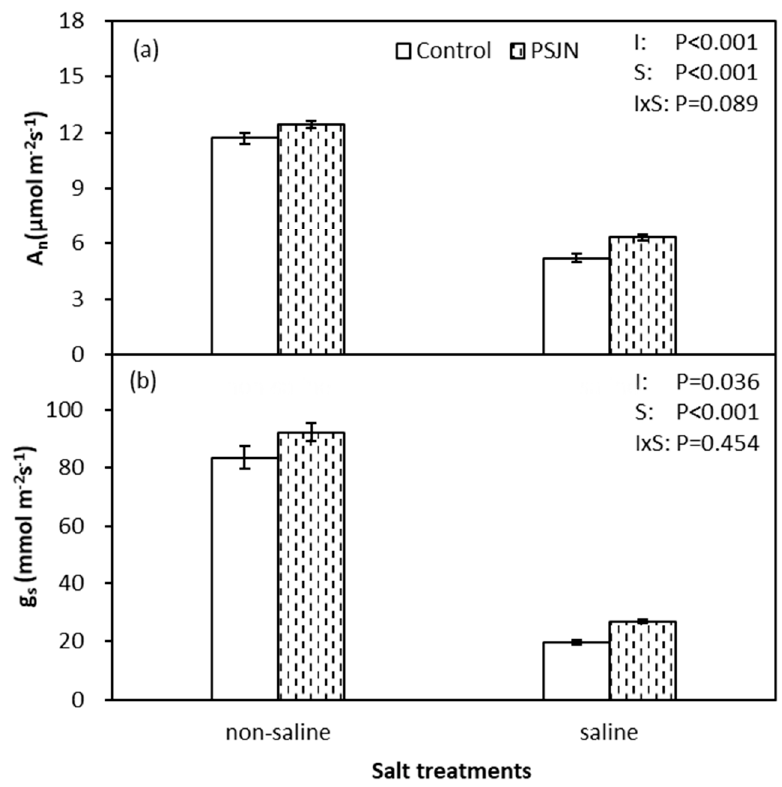
Figure 1. Photosynthetic rate (A n ) ( a ) and stomatal conductance (g s ) ( b ) of quinoa leaves a ff ected by bacterial inoculation in non-saline (0 mM NaCl) and saline (400 mM NaCl) irrigations. PsJN indicates Burkholderia phytofirmans PsJN. I and S indicate inoculation and salinity treatments, respectively, and I × S indicates the interaction. Error bars indicate standard error (S.E., n =